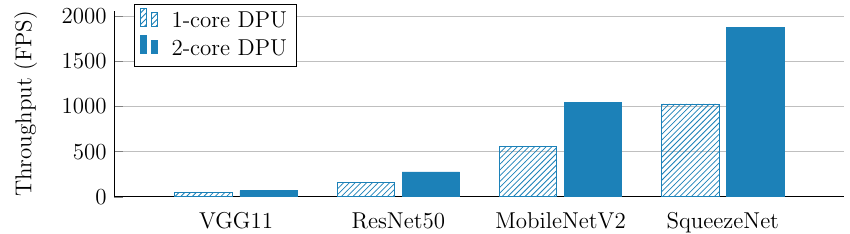
Figure 10. Throughput results for the four studied models on one and two processing cores of the